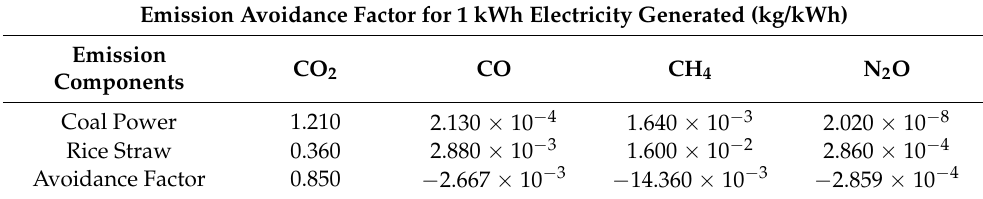
Table 7. Emission avoidance factor between coal and rice straw in producing 1 kWh [19].